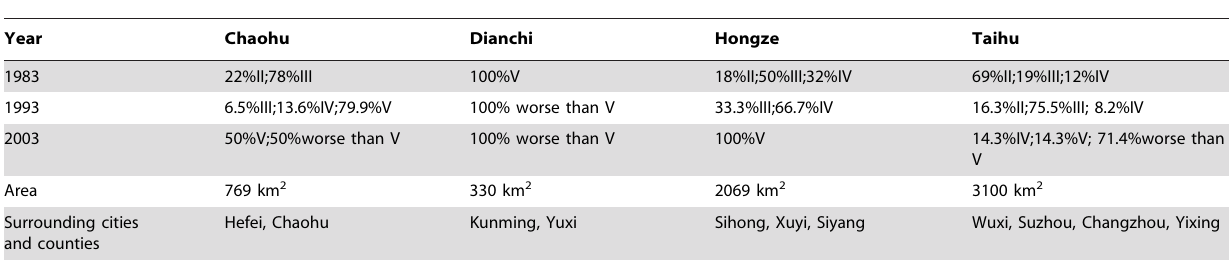
Table 1. The Background of Four Lakes [44,45,58].